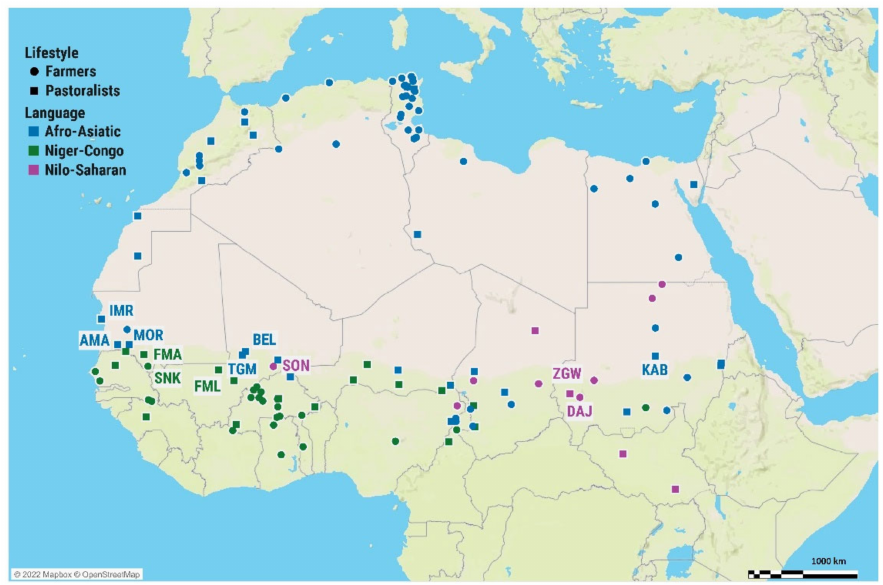
Figure 1. Geographic locations of 134 African populations included in this study. Newly ob- tained samples are marked with labels, and colors differentiate the linguistic affiliations and subsis- tence